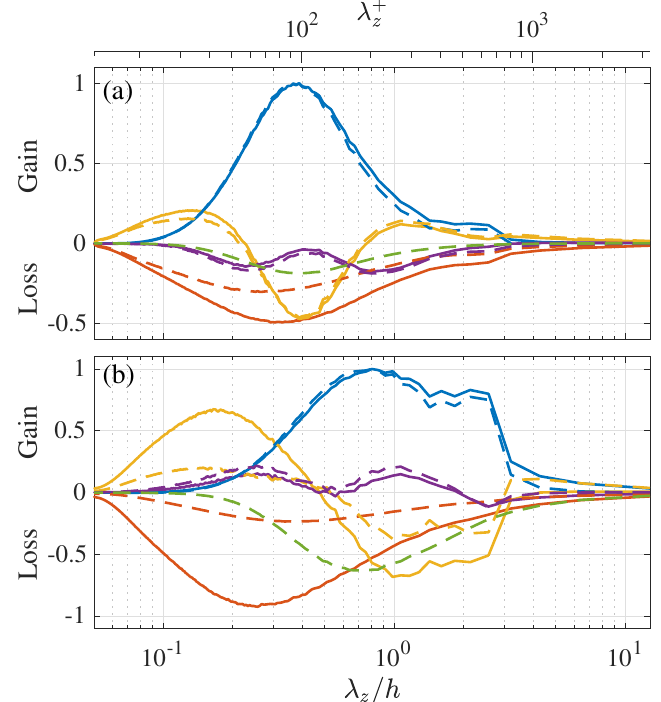
Figure 11. Detailed budget balance of the E z and E z uu transport equation at ( a ) a near-wall location θθ y + = 16 and ( b ) the quarter height of the channel y / h = 0.25: (blue) production; (red) viscous dissipation + viscous diffusion; (yellow) interscale transport; (purple) turbulent diffusion; (light green) pressure-strain cospectrum π z uu . The solid and dashed lines represent terms in the E z and E z uu θθ equations, respectively. The terms are given in the premultiplied form, and the values are scaled by the peak value of each production